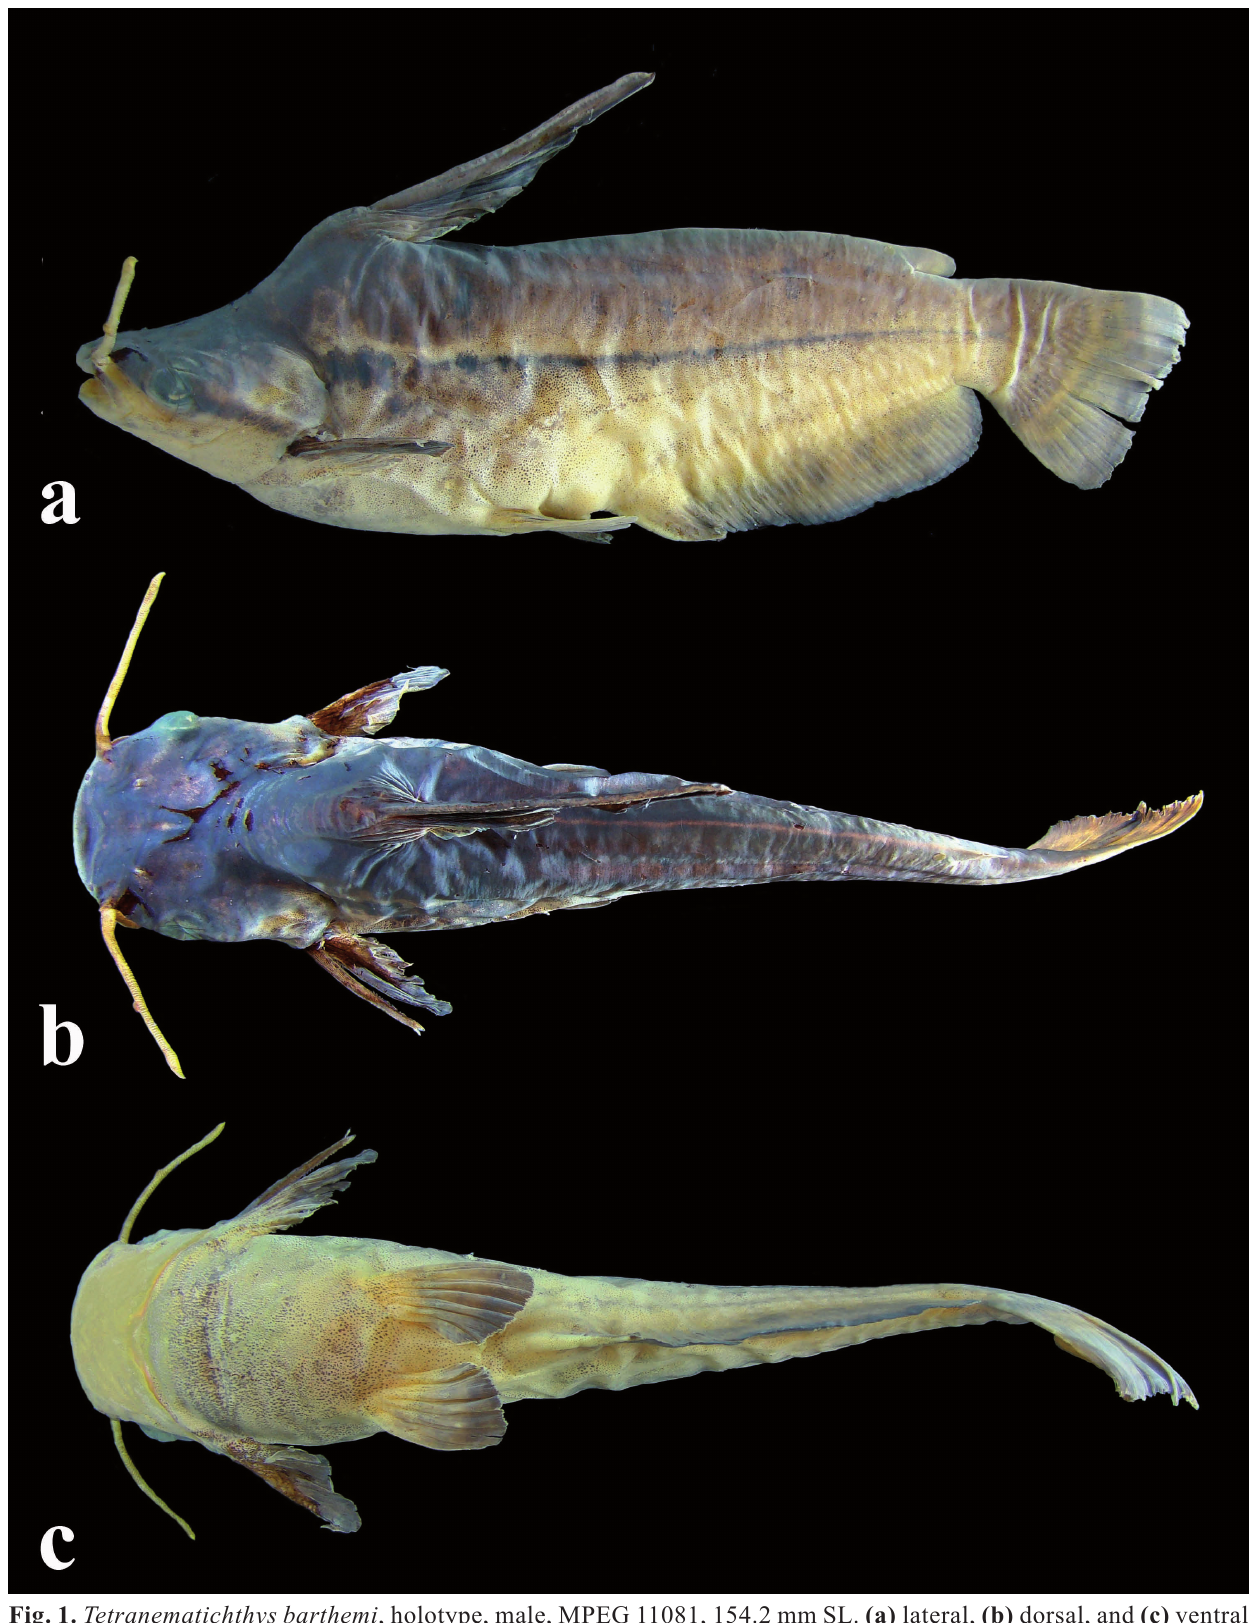
Fig. 1. Tetranematichthys barthemi , holotype, male, MPEG 11081, 154.2 mm SL. (a) lateral, (b) dorsal, and (c) ventral